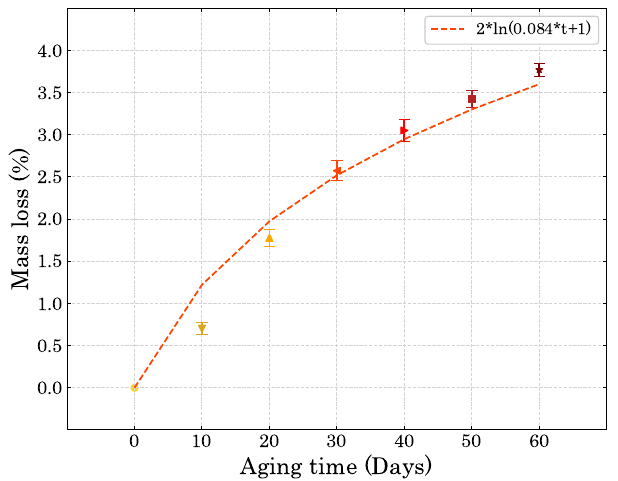
Figure 7. Mass loss of the compression specimens after the ageing